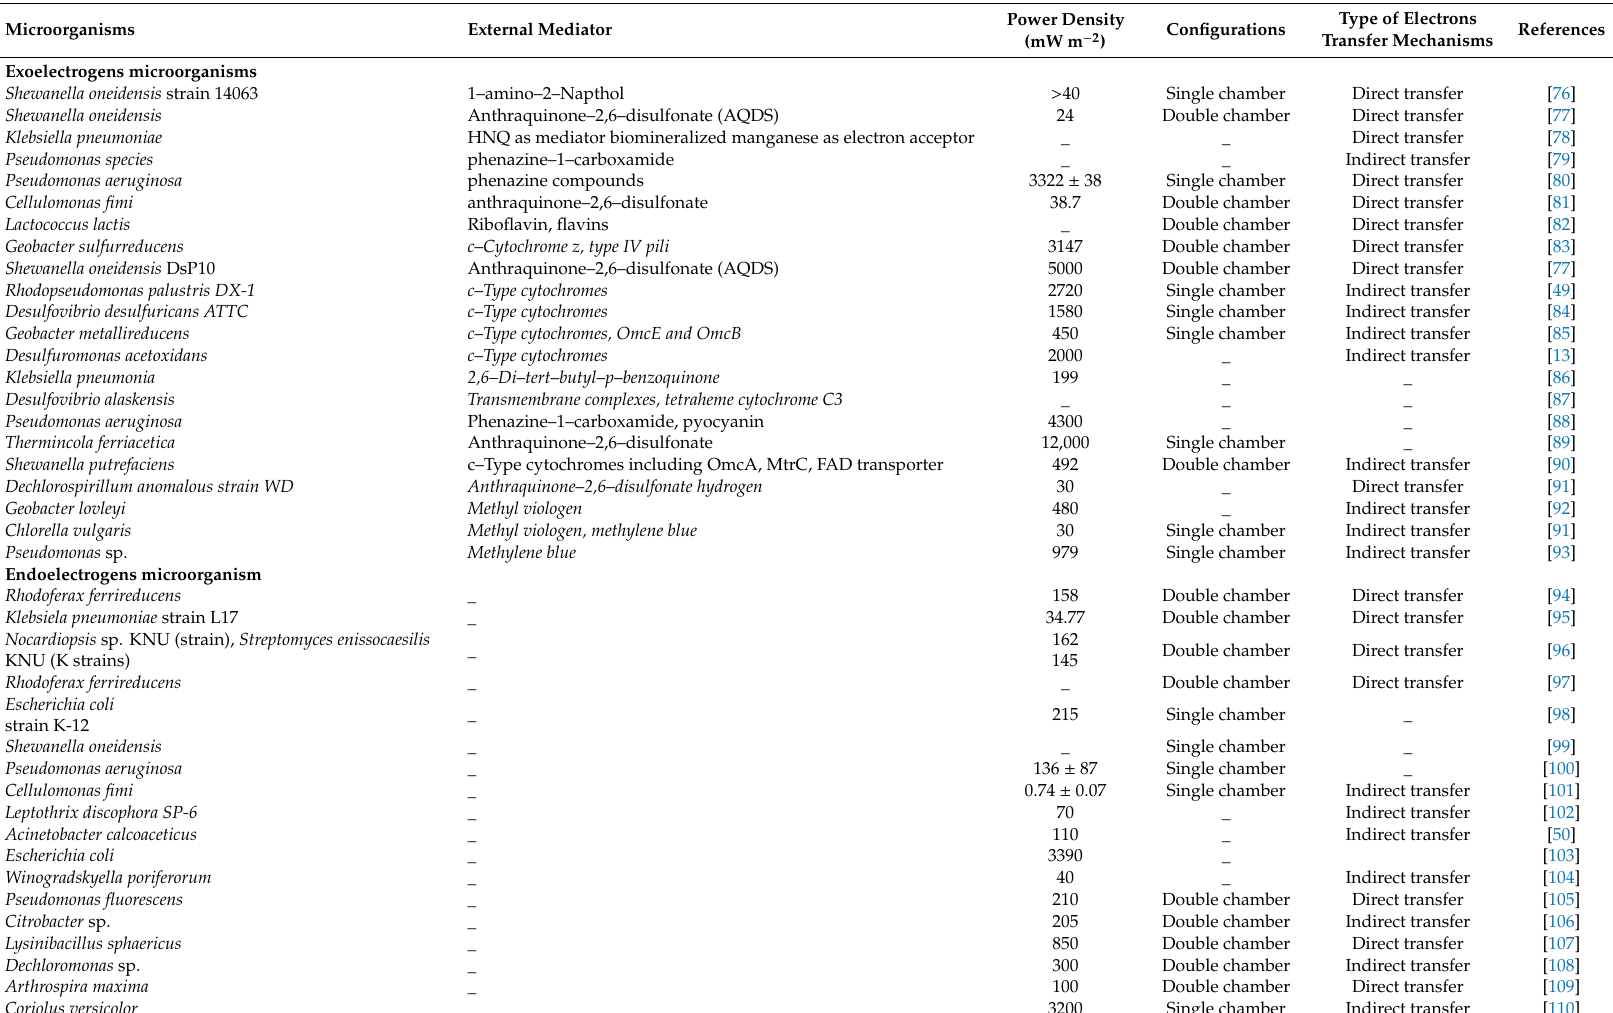
Table 1. Performance of BMFC configuration through exoelectrogens and endoelectrogens with respect to power